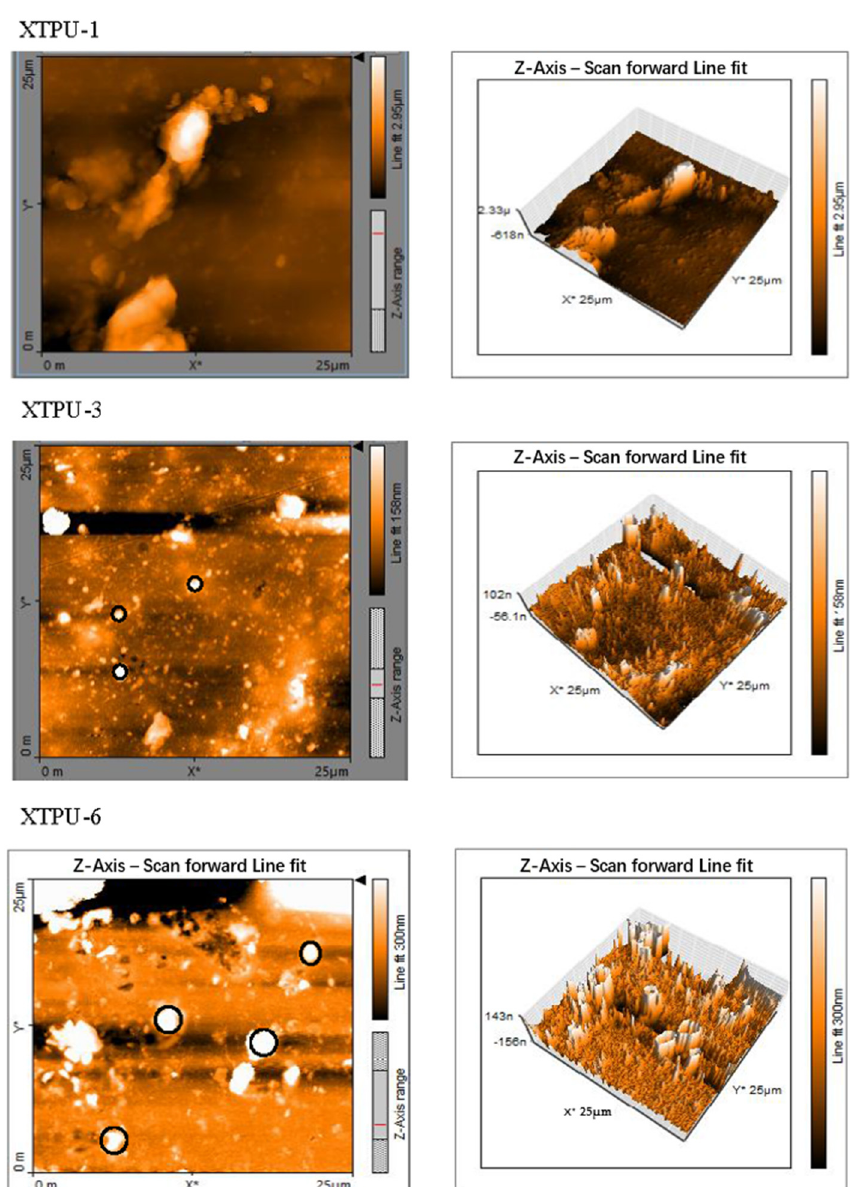
Figure 9. Three-dimensional AFM images of XTPU-1, XTPU-3, and XTPU-6 with 0%, 2%, and 5% titanium dioxide,